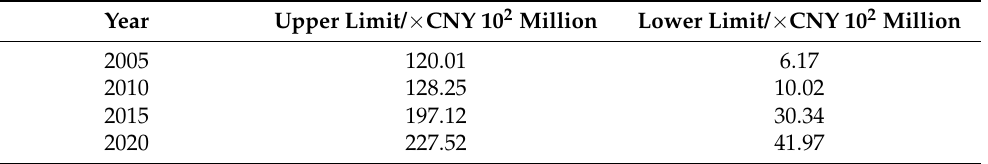
Table 5. Eco-compensation standards of Nujiang Prefecture from 2005 to